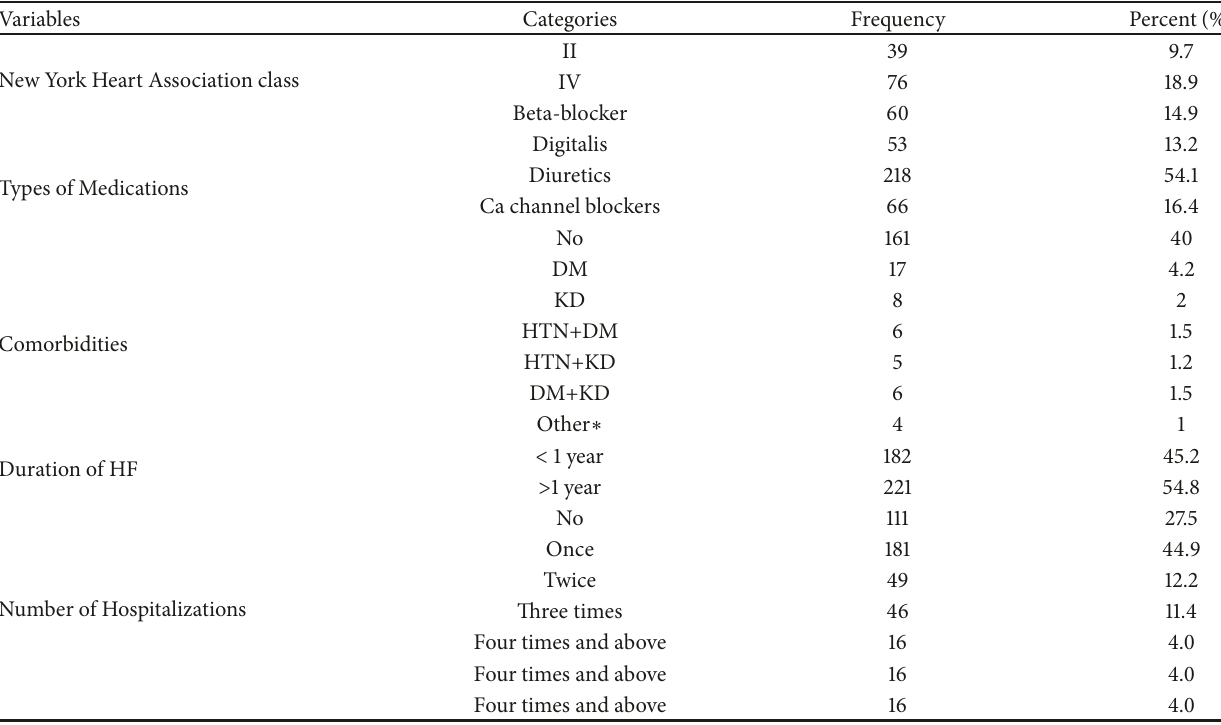
Table 2: Medical related characteristics of the respondents attending cardiac follow-up clinics at Amhara Region, Northwest Ethiopia, 30 March to 15 May 2017 G.C. (n=403).